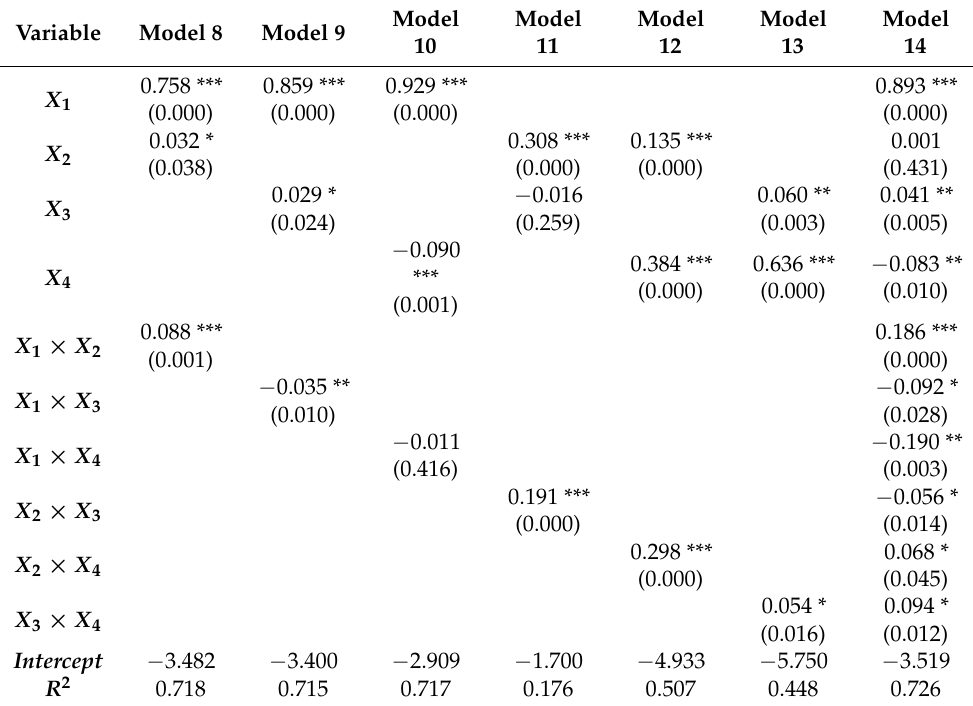
Table 6. QAP regression result of proximity